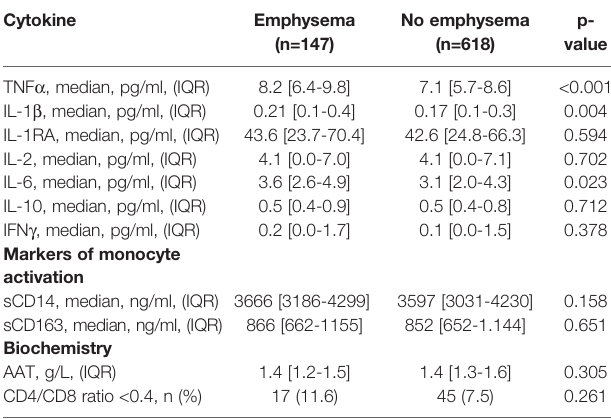
TABLE 2 | Cytokine and alpha-1 antitrypsin concentrations in PLWH with and without emphysema. Median values were calculated for cytokines with detection rates above 50%.